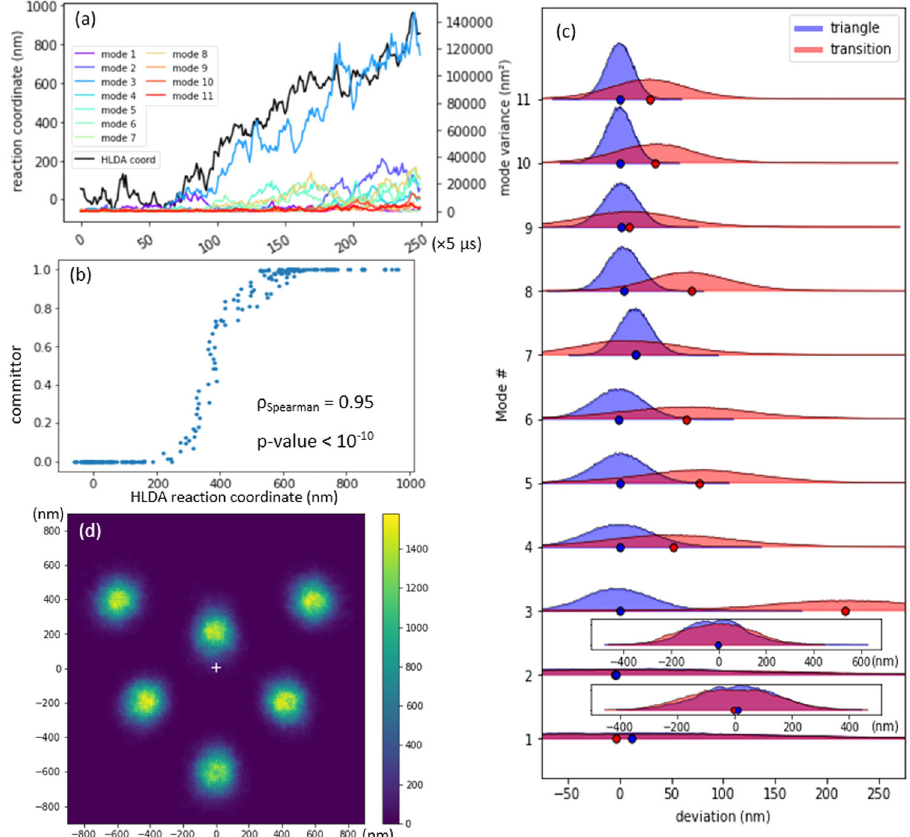
Fig. 6 Validation and analysis of the PCA-HLDA reaction coordinate. a Comparison of the HLDA reaction coordinate s HLDA and the variance of particle deviations along each of the 12 PCs over the course of a single triangle to chevron isomerization transition. b Calibration plot of the committor probability against the HLDA reaction coordinate for 250 selected con fi gurations. The high rank-order correlation ( ρ spearman = 0.95) and low scatter validates the PCA-HLDA reaction coordinate as a good measure of reaction progress. c Distribution of particle deviations from the metastable triangle con fi guration projected onto all 11 non-trivial (omitting rigid rotation) PCs over the course of the transition for con fi gurations with committor values 0.1 – 0.9 (red) and in the metastable triangle con fi guration with committor values <0.1 (blue). Means of each distribution are indicated by colored dots. PC 3 changes most markedly in moving from the metastable reactant basin of the triangle con fi guration to executing the isomerization transition. d Probability distribution of aligned particle positions computed over 395,860 con fi gurations in the transition region with 300 nm < s HLDA ( R ) < 500 nm (committor probabilities in the range 0.1 – 0.9); the white cross indicates the average center of mass of these con fi gurations. The color scheme describes the number of con fi gurations that contains a particle centered at a speci fi c